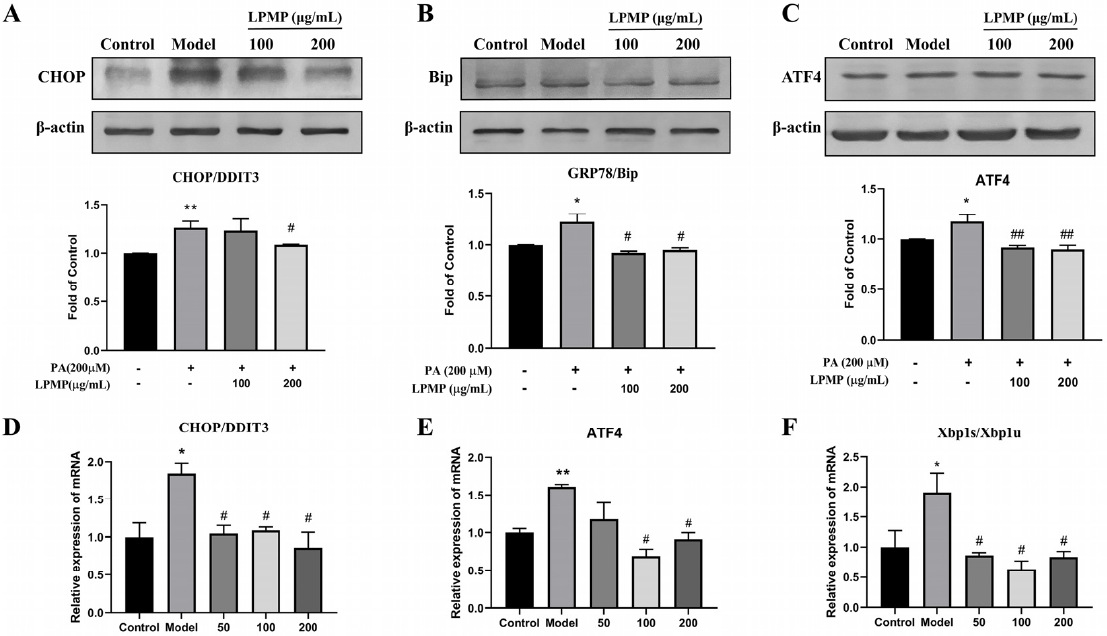
Figure 7. Effect of LPMP on endoplasmic reticulum stress. Treatment of HepG2 cells with different concentrations of LPMP for 24 h. ( A ) CHOP , ( B ) Bip, and ( C ) ATF4 protein was determined by immunoblotting. The band density was quantified and β -actin was used as a standard. The mRNA expression level of ( D ) CHOP , ( E ) ATF4 , and ( F ) Xbp1s/Xbp1u was quantified by RT-PCR. The results shown are means ± SEM ( n = 3). * p < 0.05, ** p < 0.01 versus control group; # p < 0.05, ## p < 0.01 versus model group.